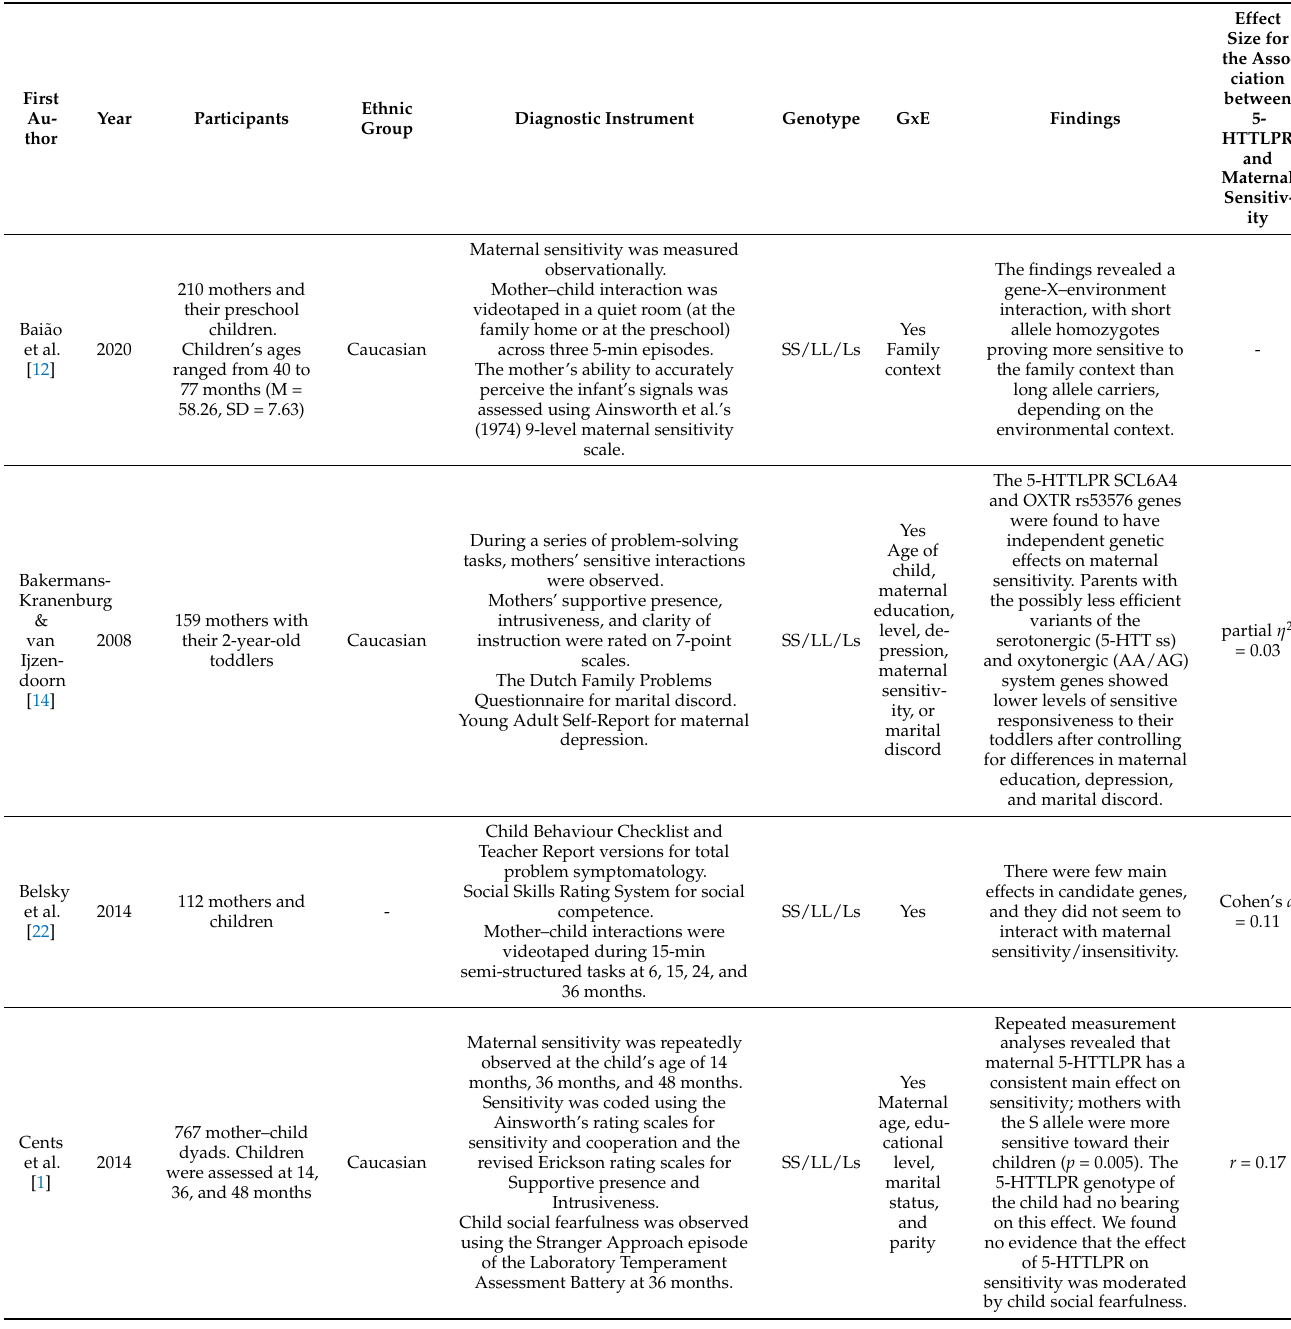
Table 2. Features of the